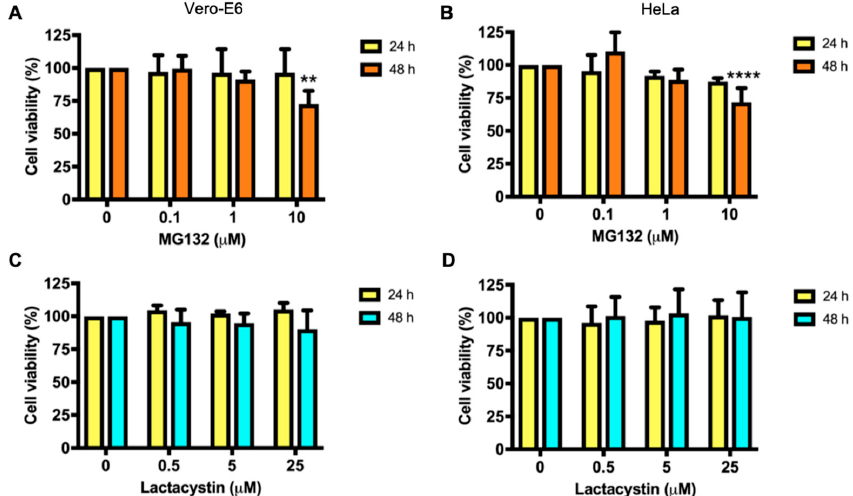
Figure 1. Cytotoxicity of proteasome inhibitors in Vero-E6 and HeLa cells. Vero-E6 ( A , C ) or HeLa ( B , D ) cells were treated with the indicated concentrations of MG132 or Lactacystin. In control cells, DMSO (0.1%) or water was added. After 24 or 48 h of treatment, cell viability was analyzed using an MTT assay. Cell viability data were analyzed with the Two-way ANOVA test using GraphPad Software and are shown as mean ± SD. Statistically significant differences are indicated: ** p < 0.01, **** p < 0.0001.